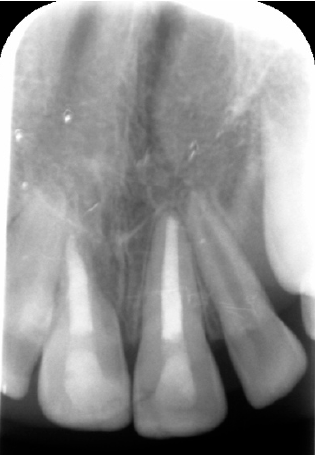
Figure 7. Radiographical follow-up 6 months after treatment.